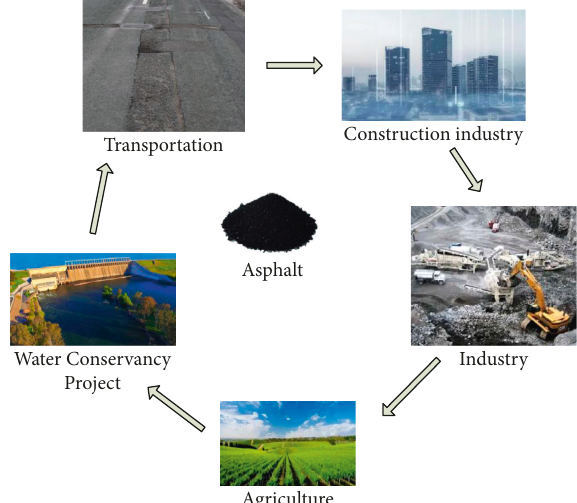
Figure 3: Application fields of petroleum